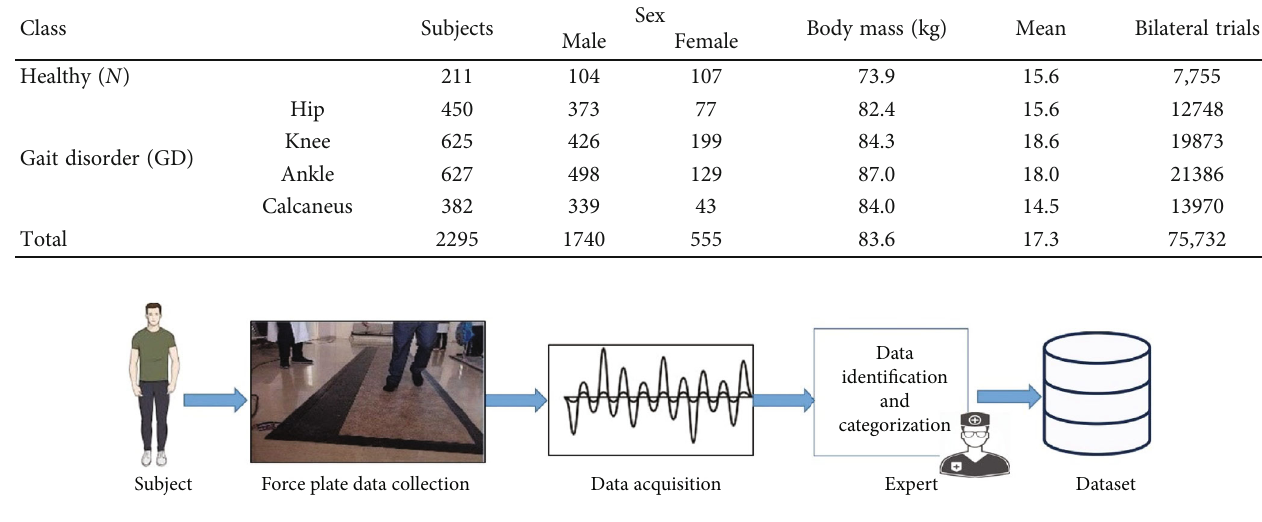
Figure 2: Schematic of gait data